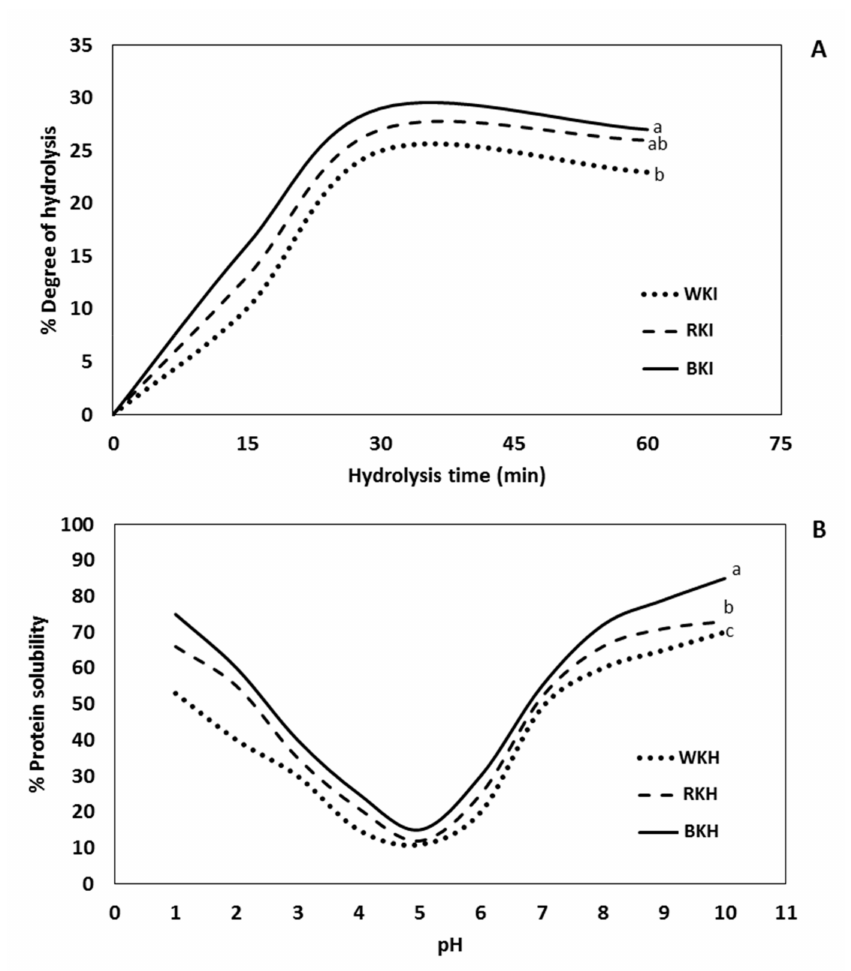
Figure 2. Hydrolysis degree ( A ) and pH-solubility curves ( B ) of black, red and white kidney seed protein hydrolysates (BKH, RKH and WKH) prepared by 30 min hydrolysis with Alcalase at 37 ◦ C and pH 6. Means with different lowercase letters indicate significant differences at p ≤ 0.05 by